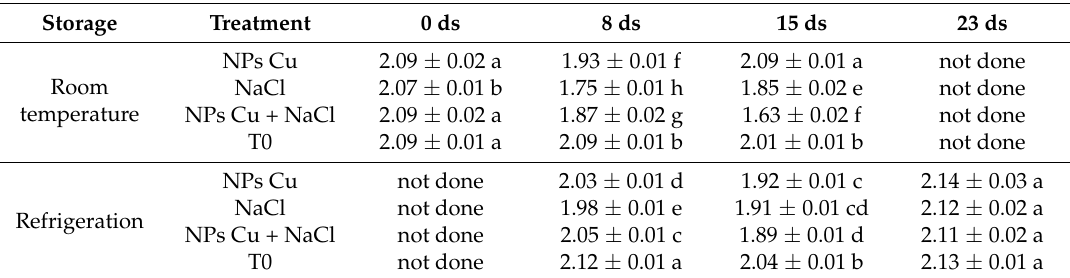
Table 6. 2,2 (cid:48) -diphenyl-1-picrylhydrazyl (DPPH) antioxidant capacity ( µ M Trolox equivalents per gram of fresh weight) in tomato fruits at different storage times at room temperature (24 ± 1 ◦ C) and refrigeration (4 ± 1 ◦ C and relative humidity at